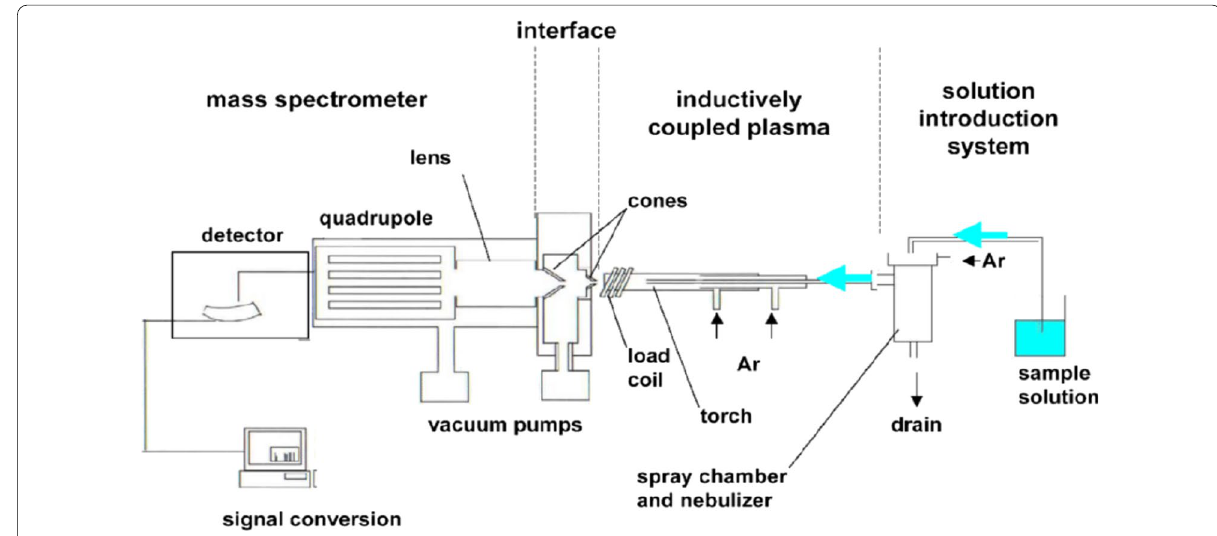
Fig. 4 Schematic diagram of ICP-MS instrument (Gilstrap Jr 2009)